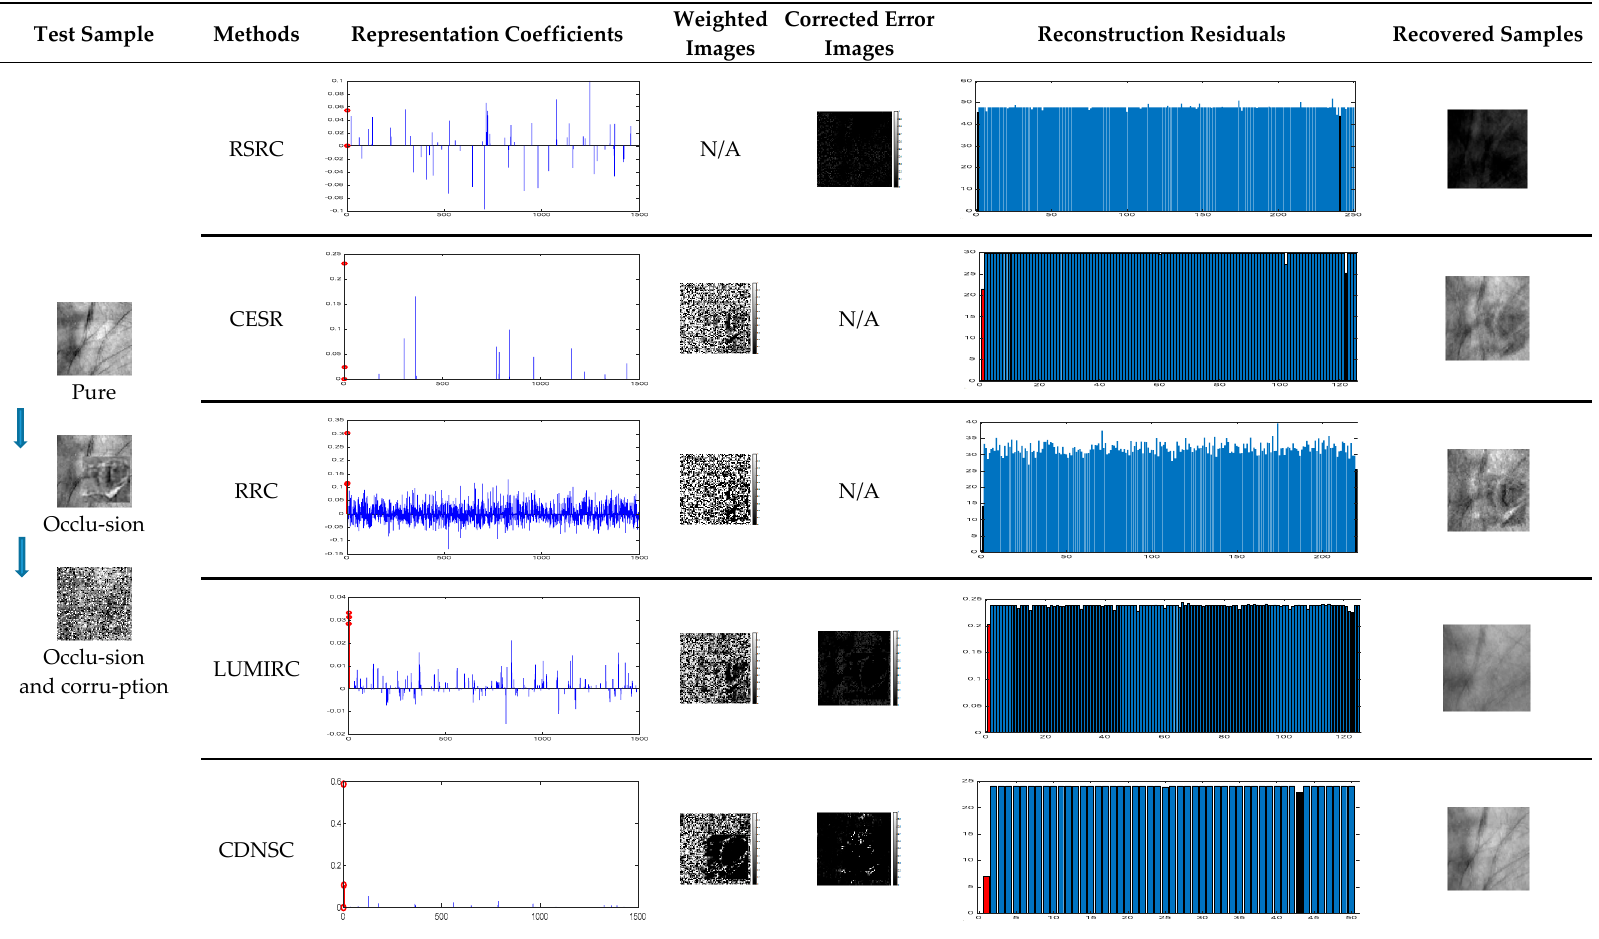
Figure 3. Comprehensive comparisons between CDNSC and the state-of-the-art methods.